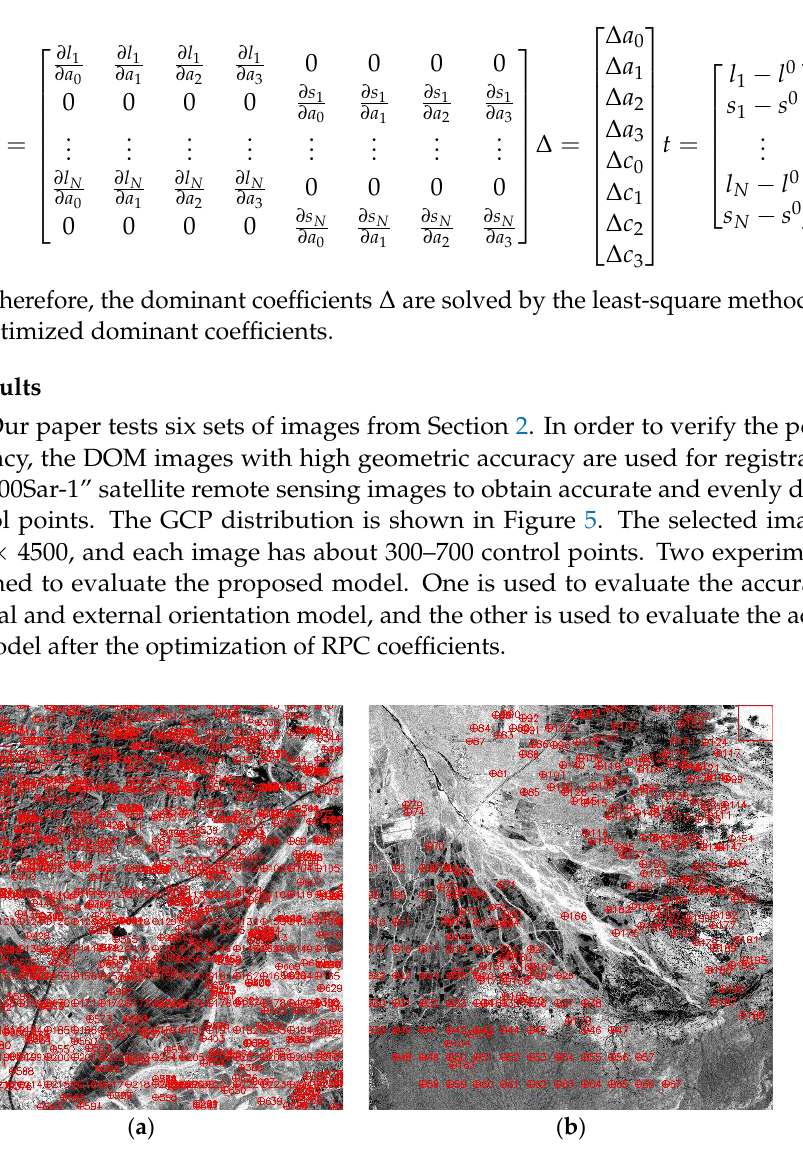
Figure 5. Distributions of GCPs in ( a ) image 0430-Baotou-43, ( b ) image 0614-Dunhuang-43.